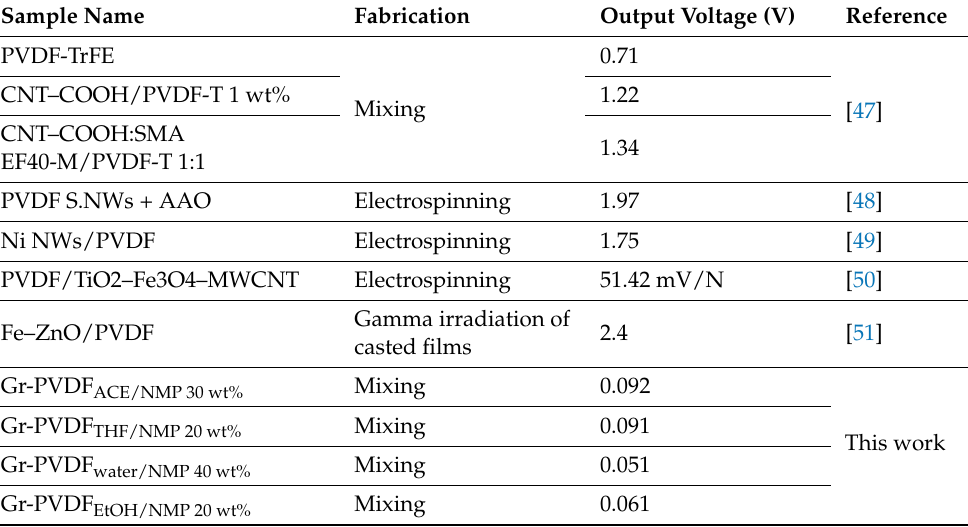
Table 1. Comparison of various types of PVDF piezoelectric films to the resulting output